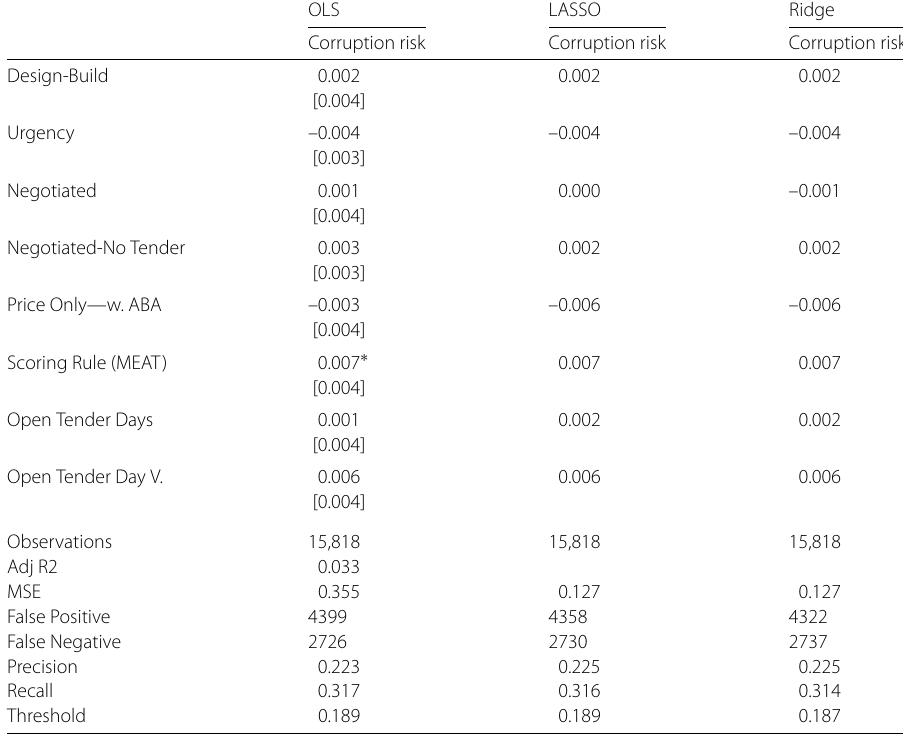
Table A.4 Estimates for the small model—consolidated Data OLS LASSO Ridge Corruption risk Corruption risk Corruption